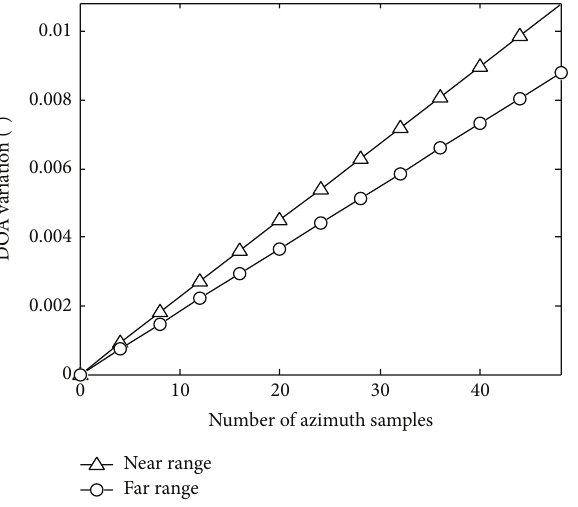
Figure 8: DOA variation versus number of azimuth samples.